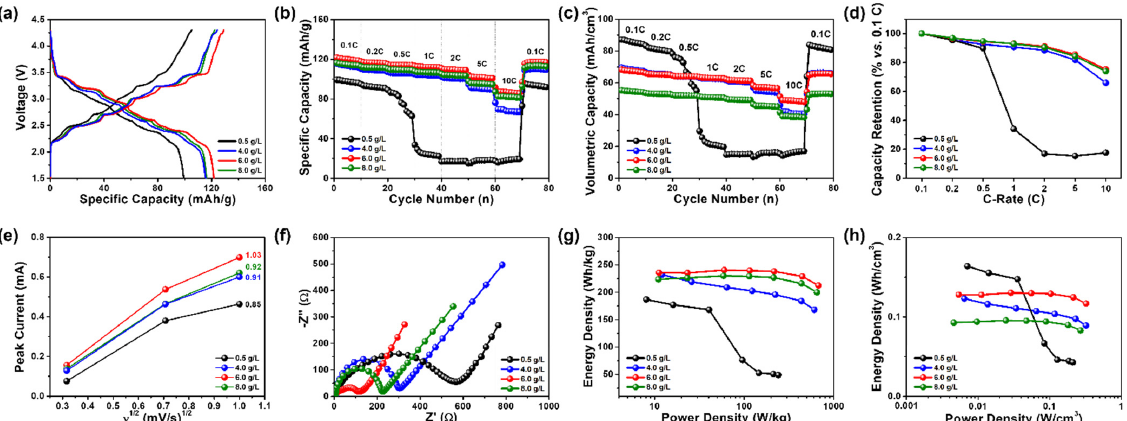
Figure 3. ( a ) The galvanostatic charge/discharge voltage profiles measured in range of 1.5–4.3 V at